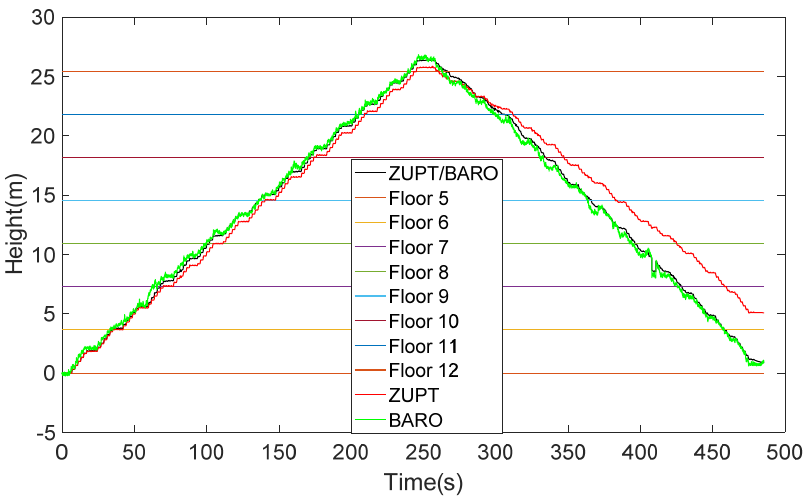
Figure 16. Height comparison of different methods .